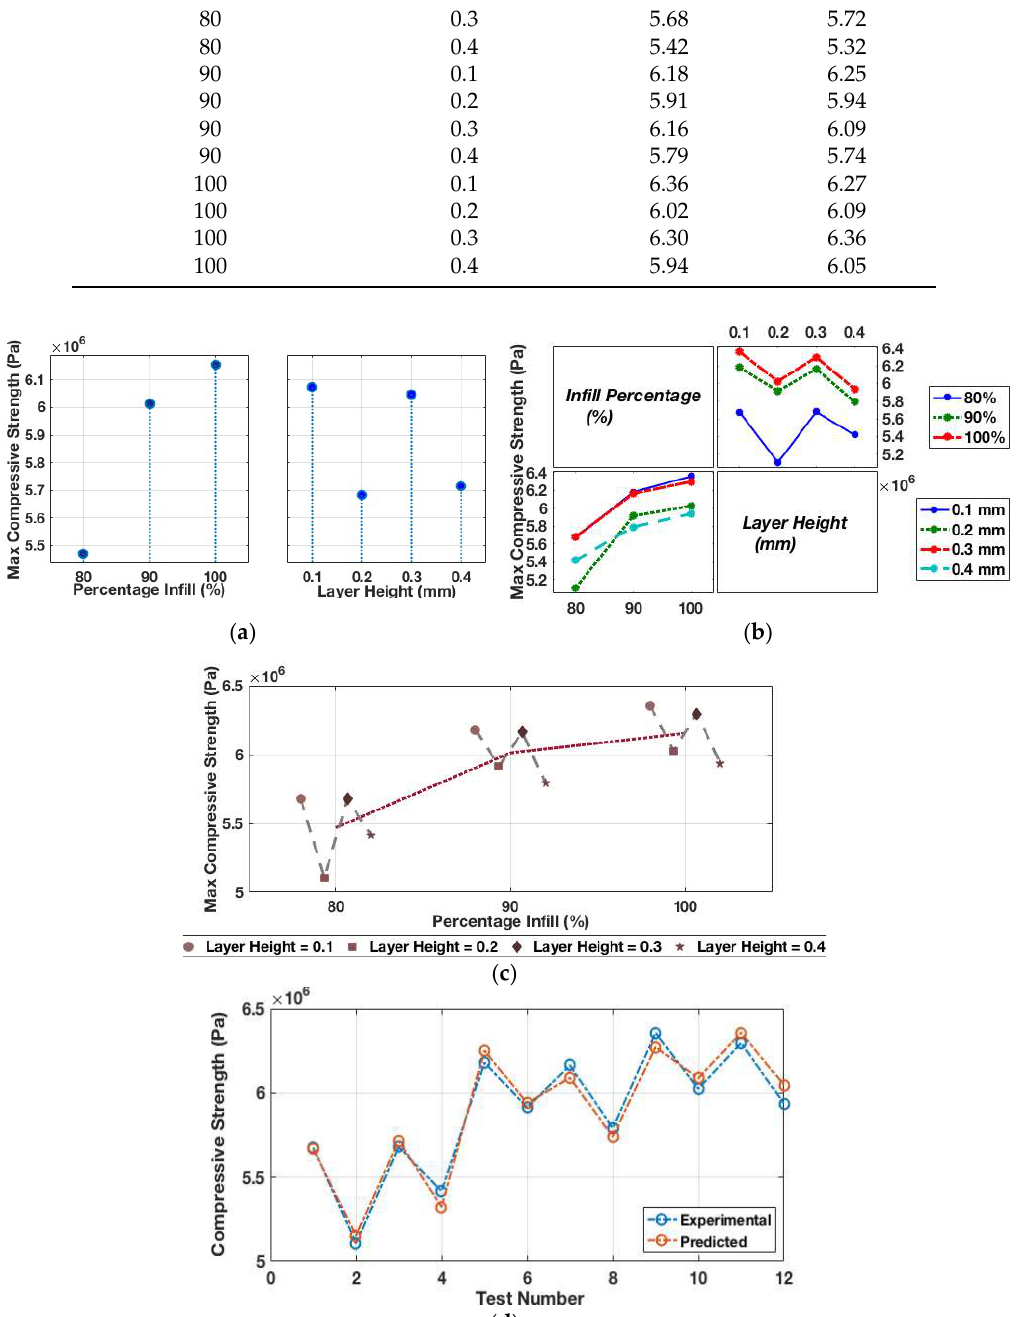
Figure 6. ( a ) Main effect plot of each factor for compression tests at ~2500 s –1 . ( b ) Interaction plot for high strain compression tests at 2500 s –1 . ( c ) Multivariate plots for high strain rate compressive tests. ( d ) Experimental versus predicted compressive strength at a constant strain rate of ~2500 s –1 .